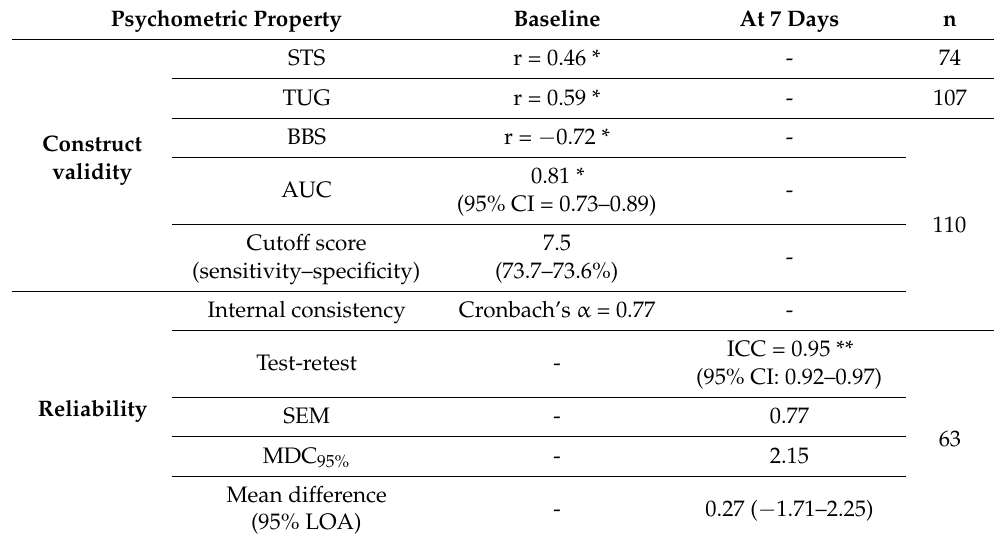
Table 4. Psychometric properties of the Arabic FRQ.